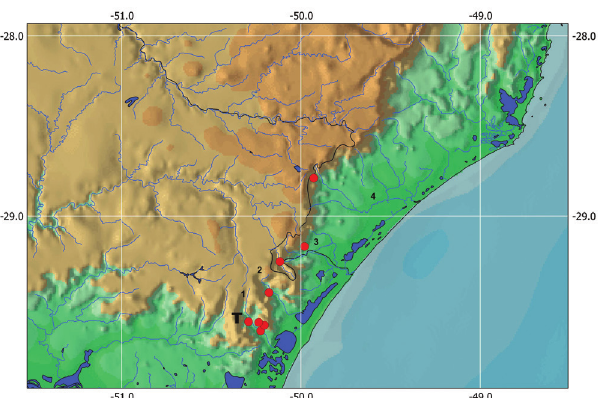
Fig. 8. Distribution of Hollandichthys taramandahy , new species (red circles), in the rio Tramandaí system (1- rio Ma- quiné, 2- rio Três Forquilhas), and rio Mampituba (3) and rio Araranguá (4) drainages. Some symbols represent more than one locality or lot of specimens. T = type locality.